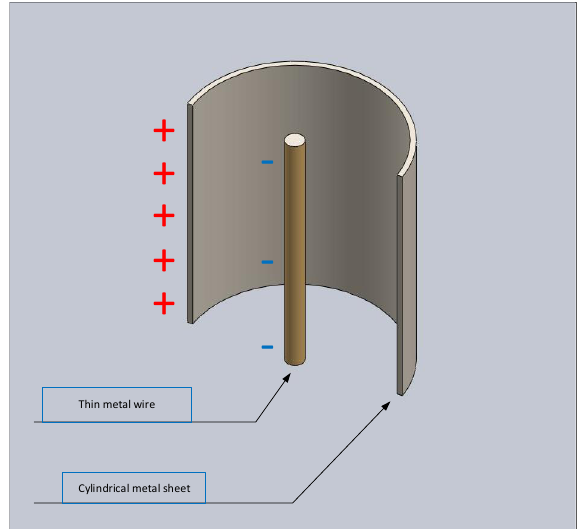
Figure 1. Internal construction of the proposed static electrostatic generator